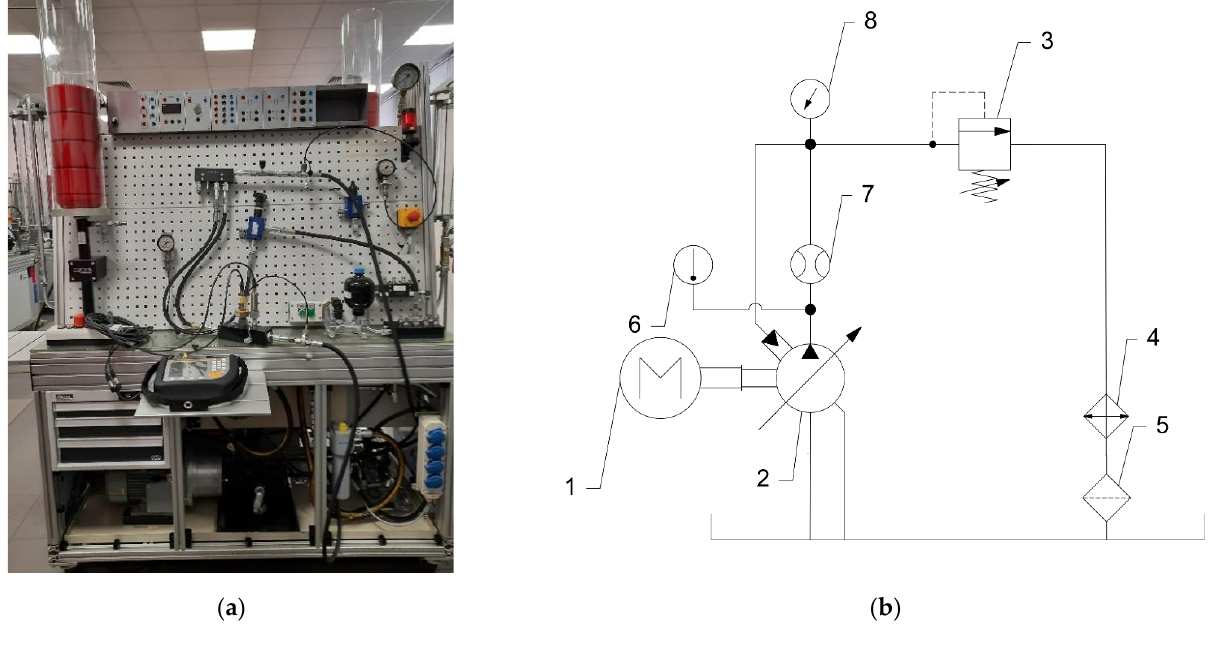
Figure 6. The test station: ( a ) station; ( b ) hydraulic scheme: 1 — motor, 2 — tested pump, 3 — pressure relief valve (load valve), 4 — cooler, 5 — filter, 6 — temperature sensor, 7 — flowmeter, 8 — pressure sensor.